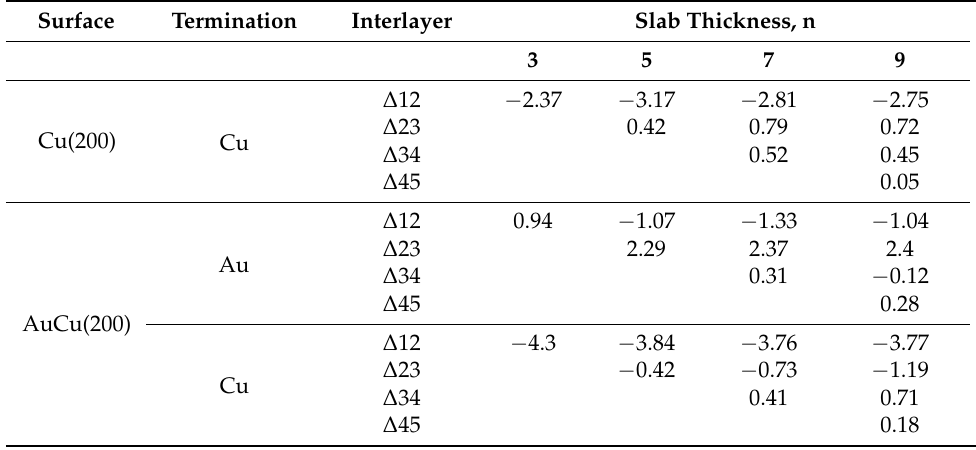
Table 1. The calculated surface atomic relaxations. Units are in % of the theoretical interlayer spacing of the corresponding